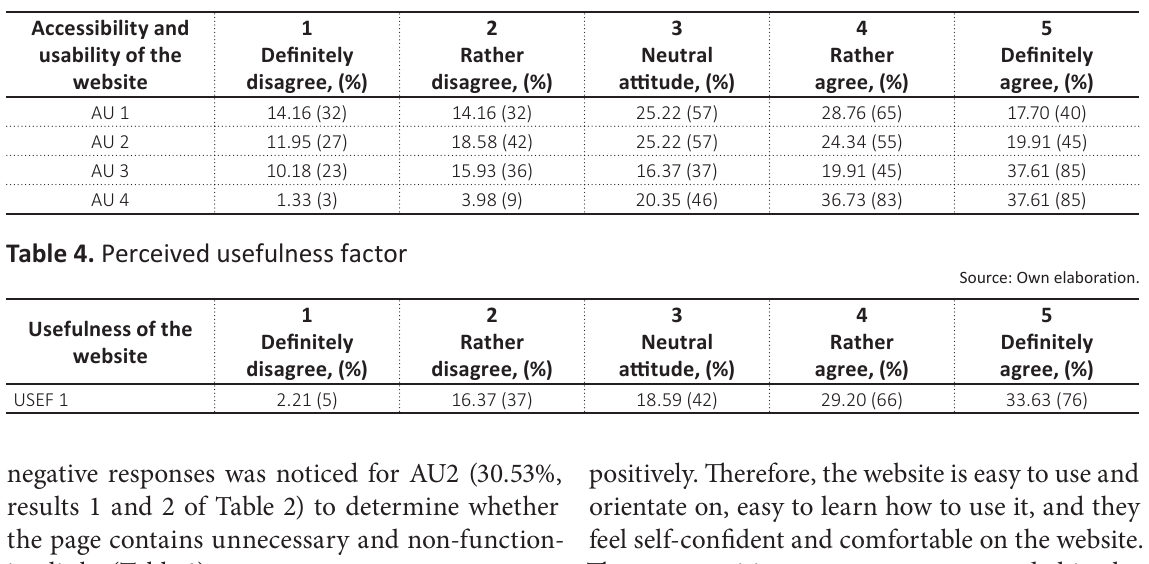
Table 3. Access and usability factor of the website